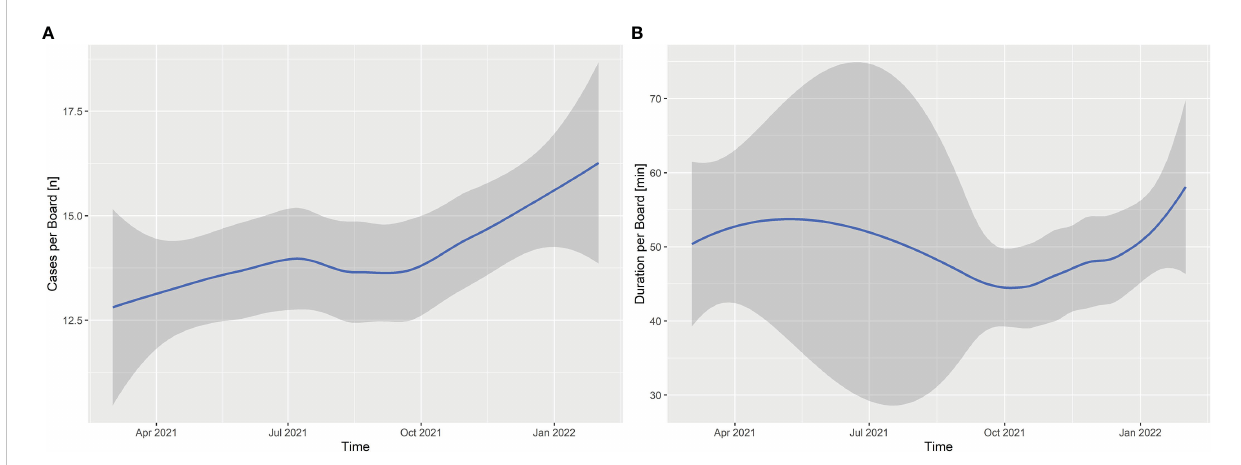
FIGURE 1 Interdisciplinary tumor boards: (A) the mean number of cases discussed per board meeting across 12 ITBs (total n = 7,123) between March 2021 and January 2022; (B) the median duration of interdisciplinary tumor board meetings (min). The gray area represents pointwise 95% con fi dence